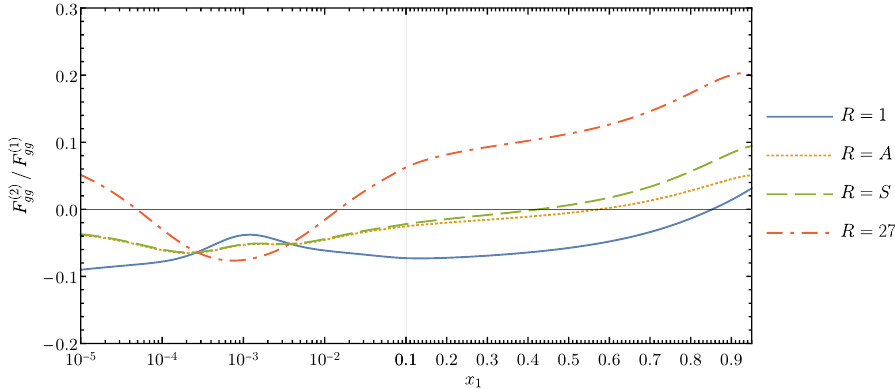
Figure 10 . As figure 9(c) but for µ y = 80 GeV and α s (80 GeV) = 0 . 120 . The corresponding curves for µ = 5 GeV are similar in shape but differ in overall size, with absolute values up to 0 . 3 y for R = 27 and up to 0 . 2 for the octets and the singlet.